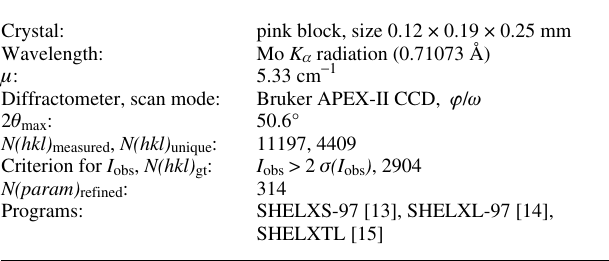
Table 1. Data collection and